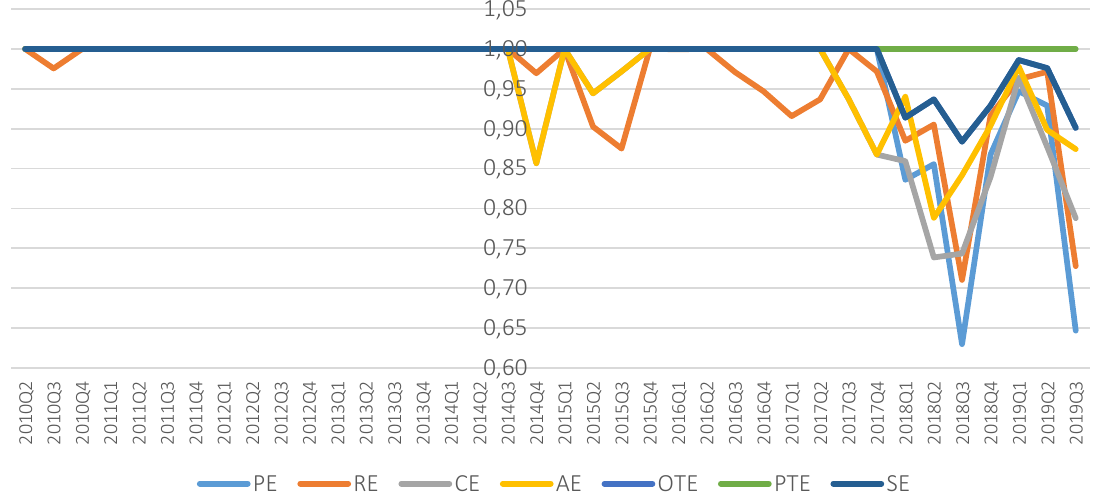
Figure 3. Efficiency measures of the NCB over the sample